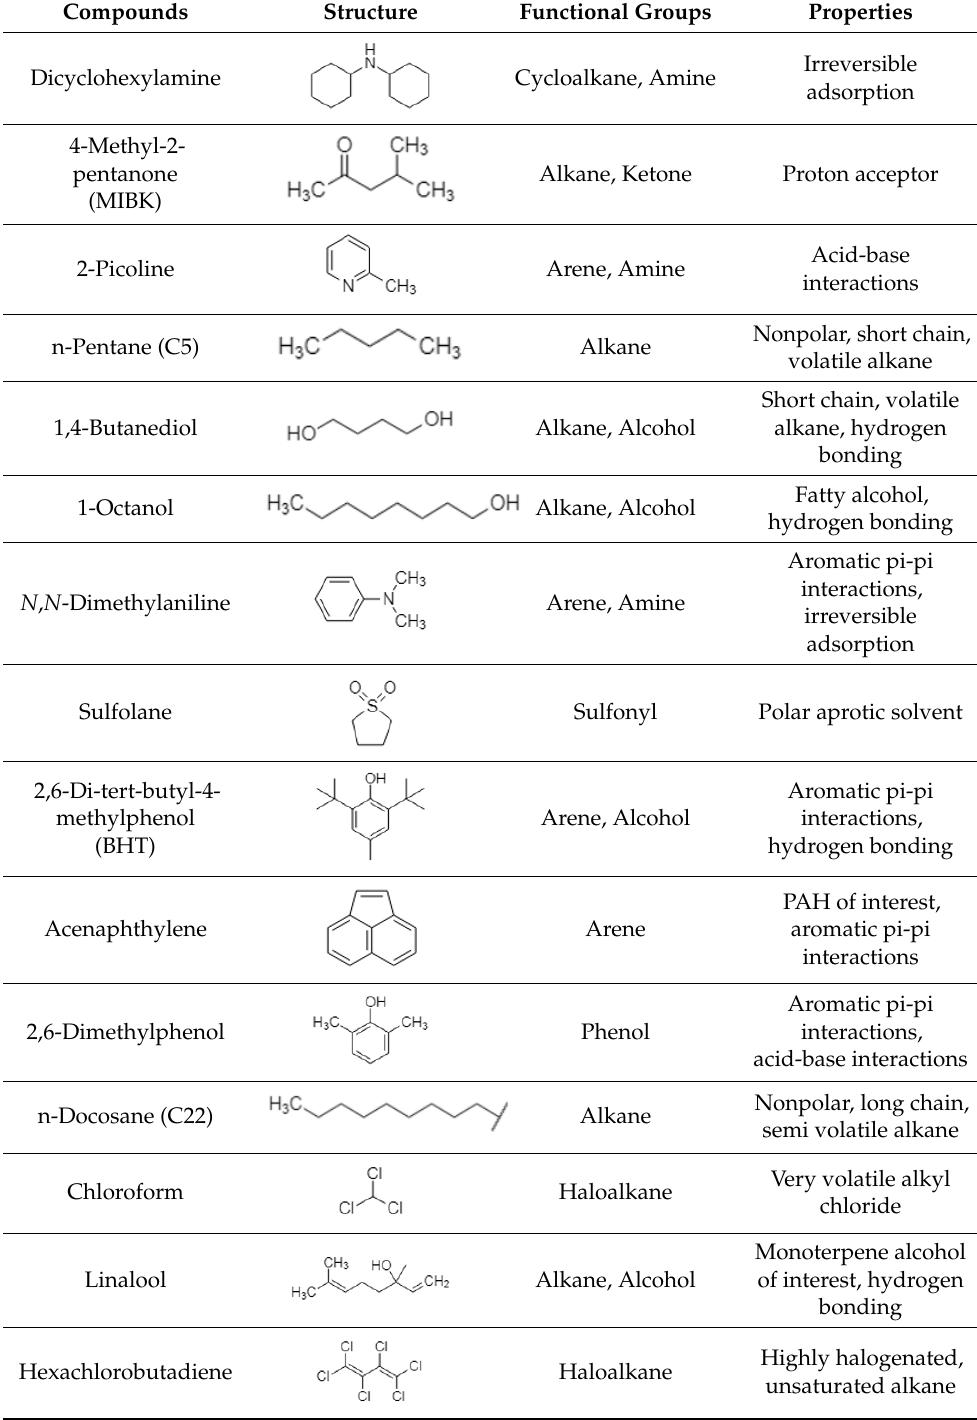
Table 1. Custom test mix used to evaluate SPME fiber performance across a range of functional groups.